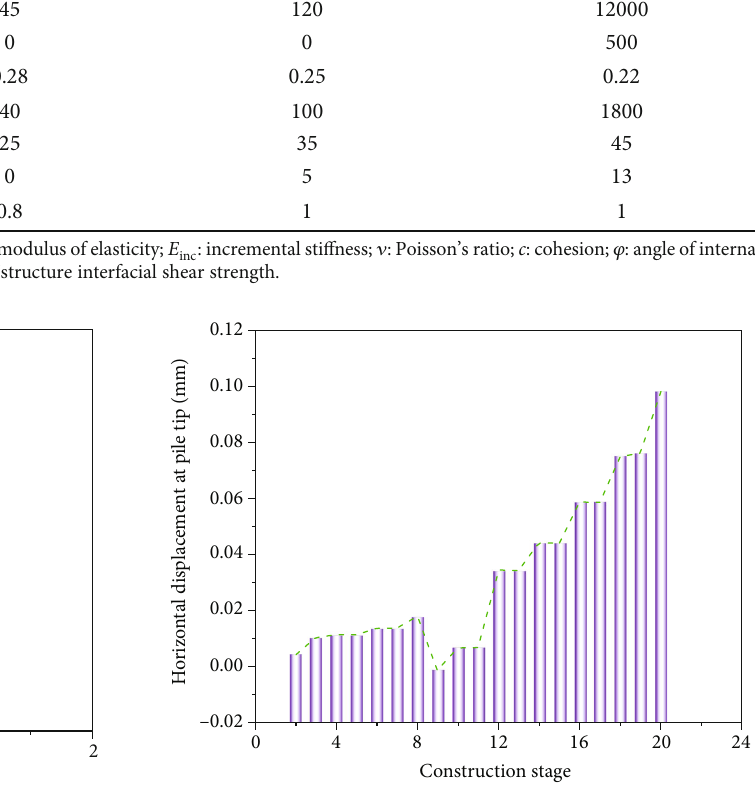
Figure 14: Variation of horizontal displacement at the end- suspended pile tip with a construction